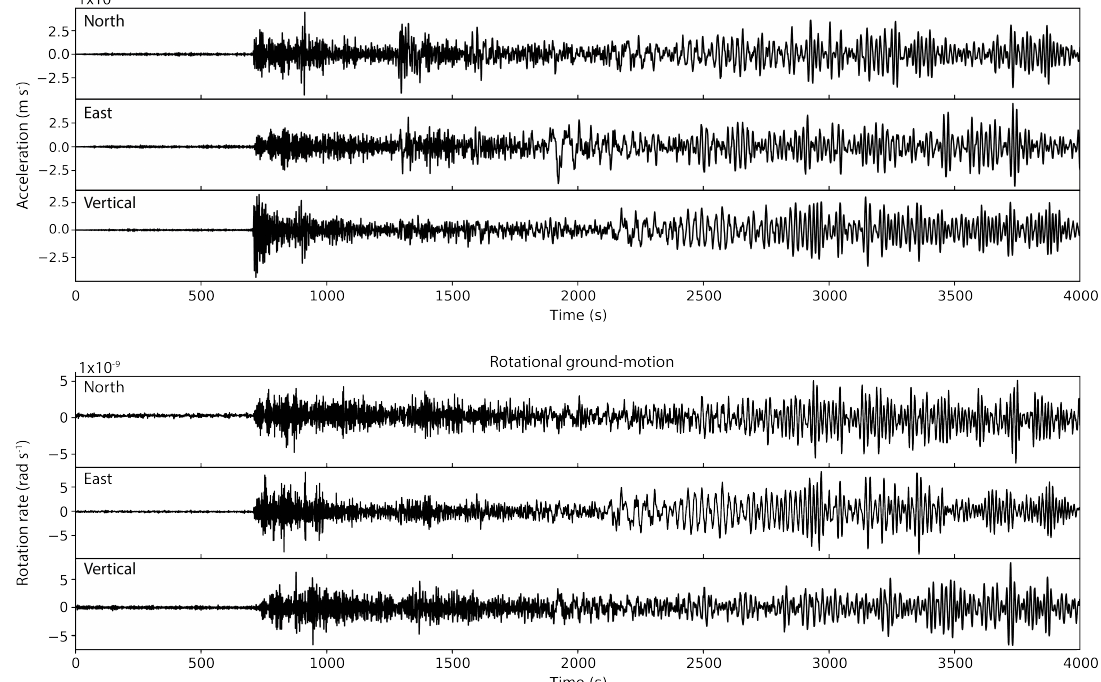
Figure 2. Six-degree-of-freedom (6DOF) recording of the M7.9 23 January 2018, gulf of Alaska earthquake (occurence time: 2018-01-23 09:31:40 UTC) at the geophysical observatory in Fürstenfeldbruck, Germany. Rotational data were recorded by the large multi-component ring laser ROMY and translational data were recorded by a collocated